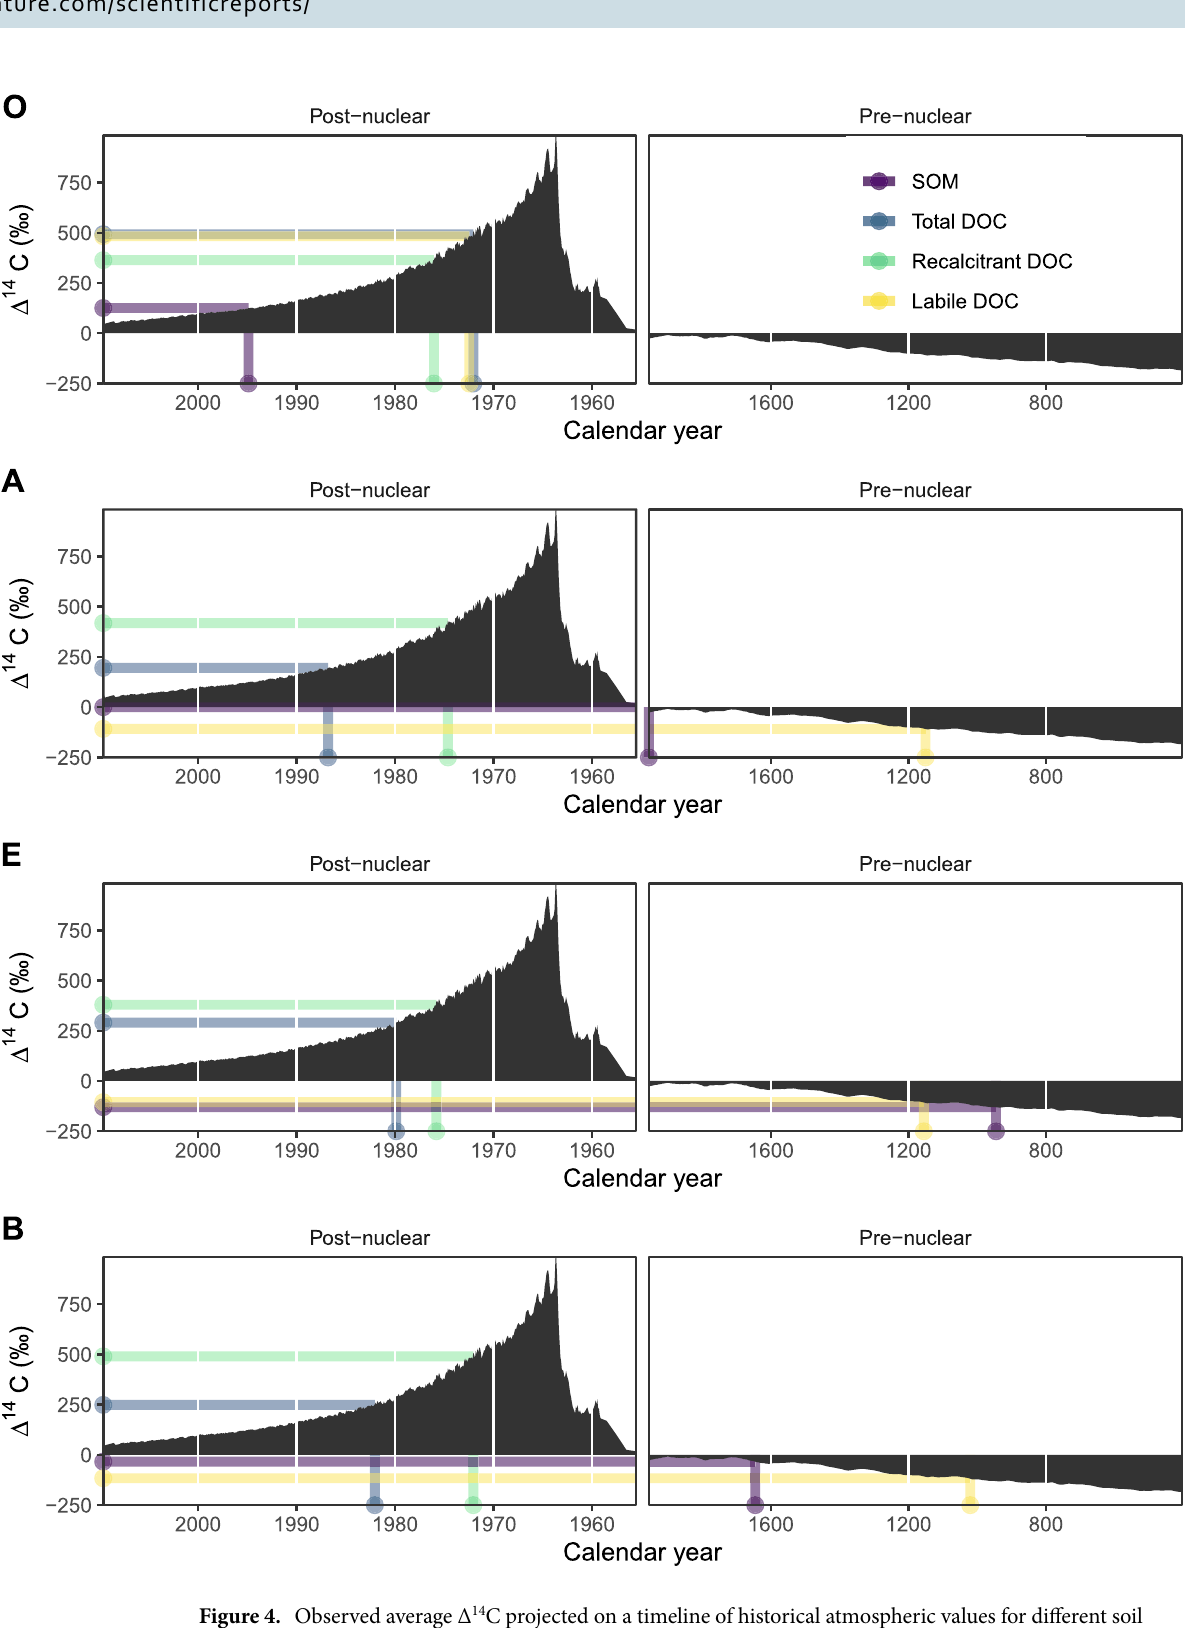
Figure 4. Observed average Δ 14 C projected on a timeline of historical atmospheric values for different soil organic matter (SOM) and dissolved organic carbon (DOC) fractions; SOM (purple), total (blue), recalcitrant (green) and labile (yellow)